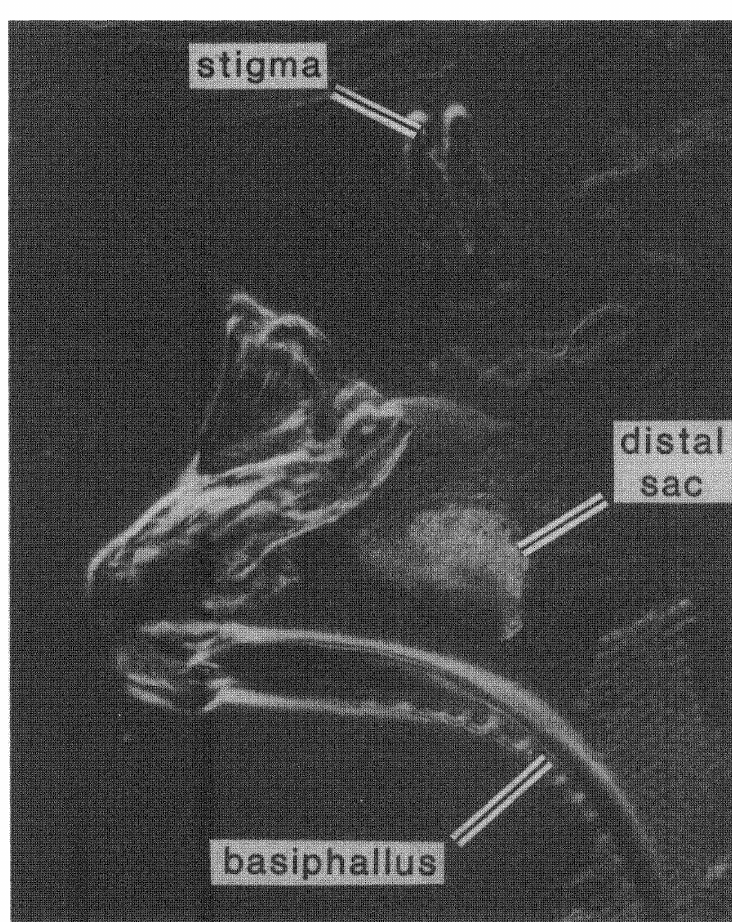
Fig. 11. Wholemount of male genitalia in the vagina posterior to the stigma after 2 min of copulation. The distiphallus appears to be in the process of unfolding.